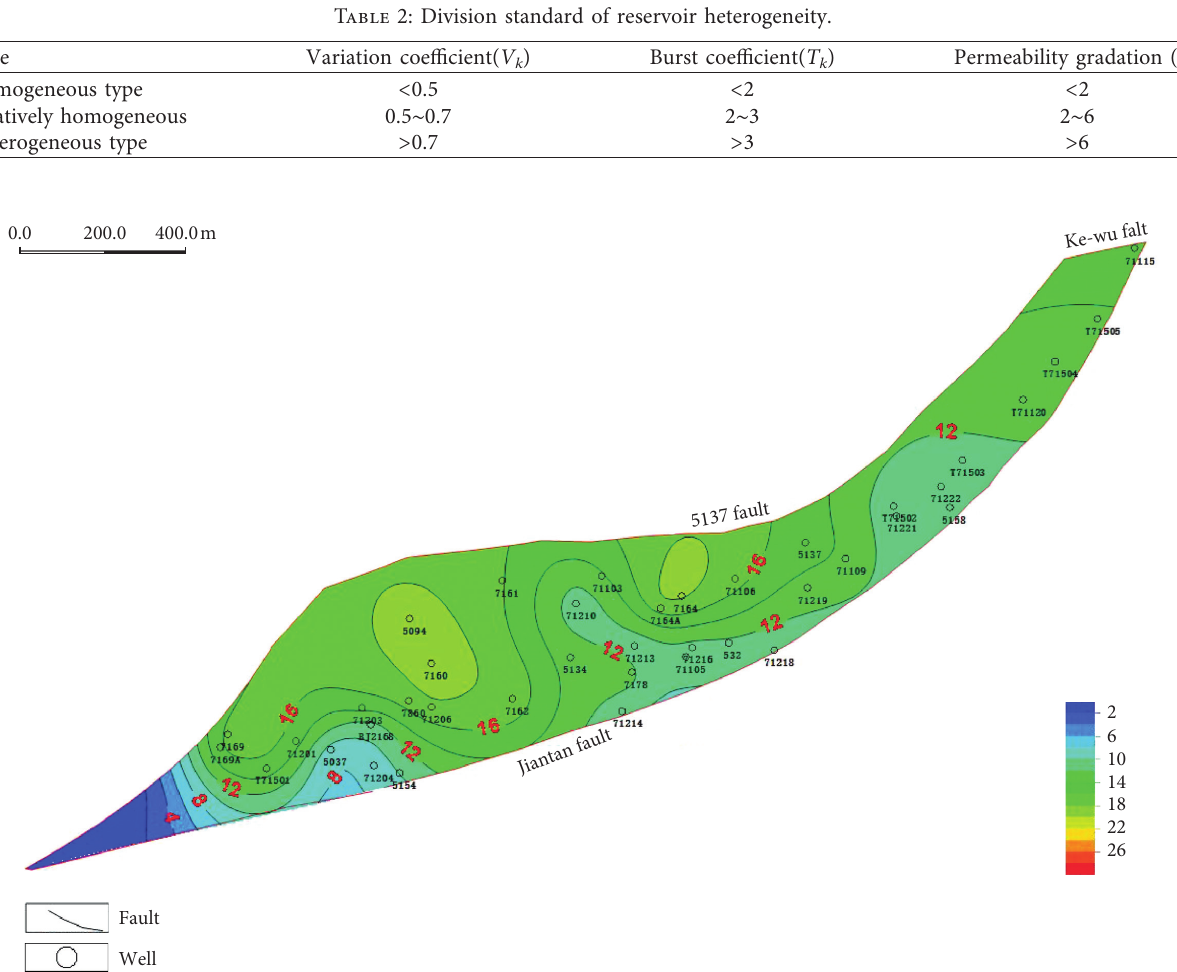
7 sand formation.